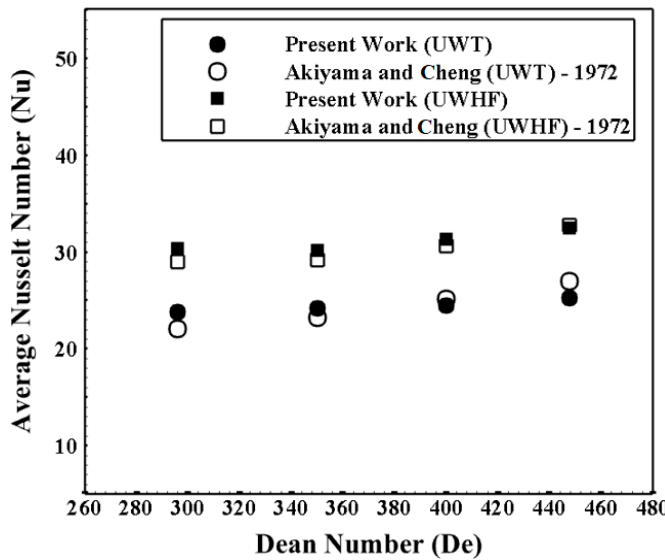
Figure 7. The outcomes of the verification investigation.